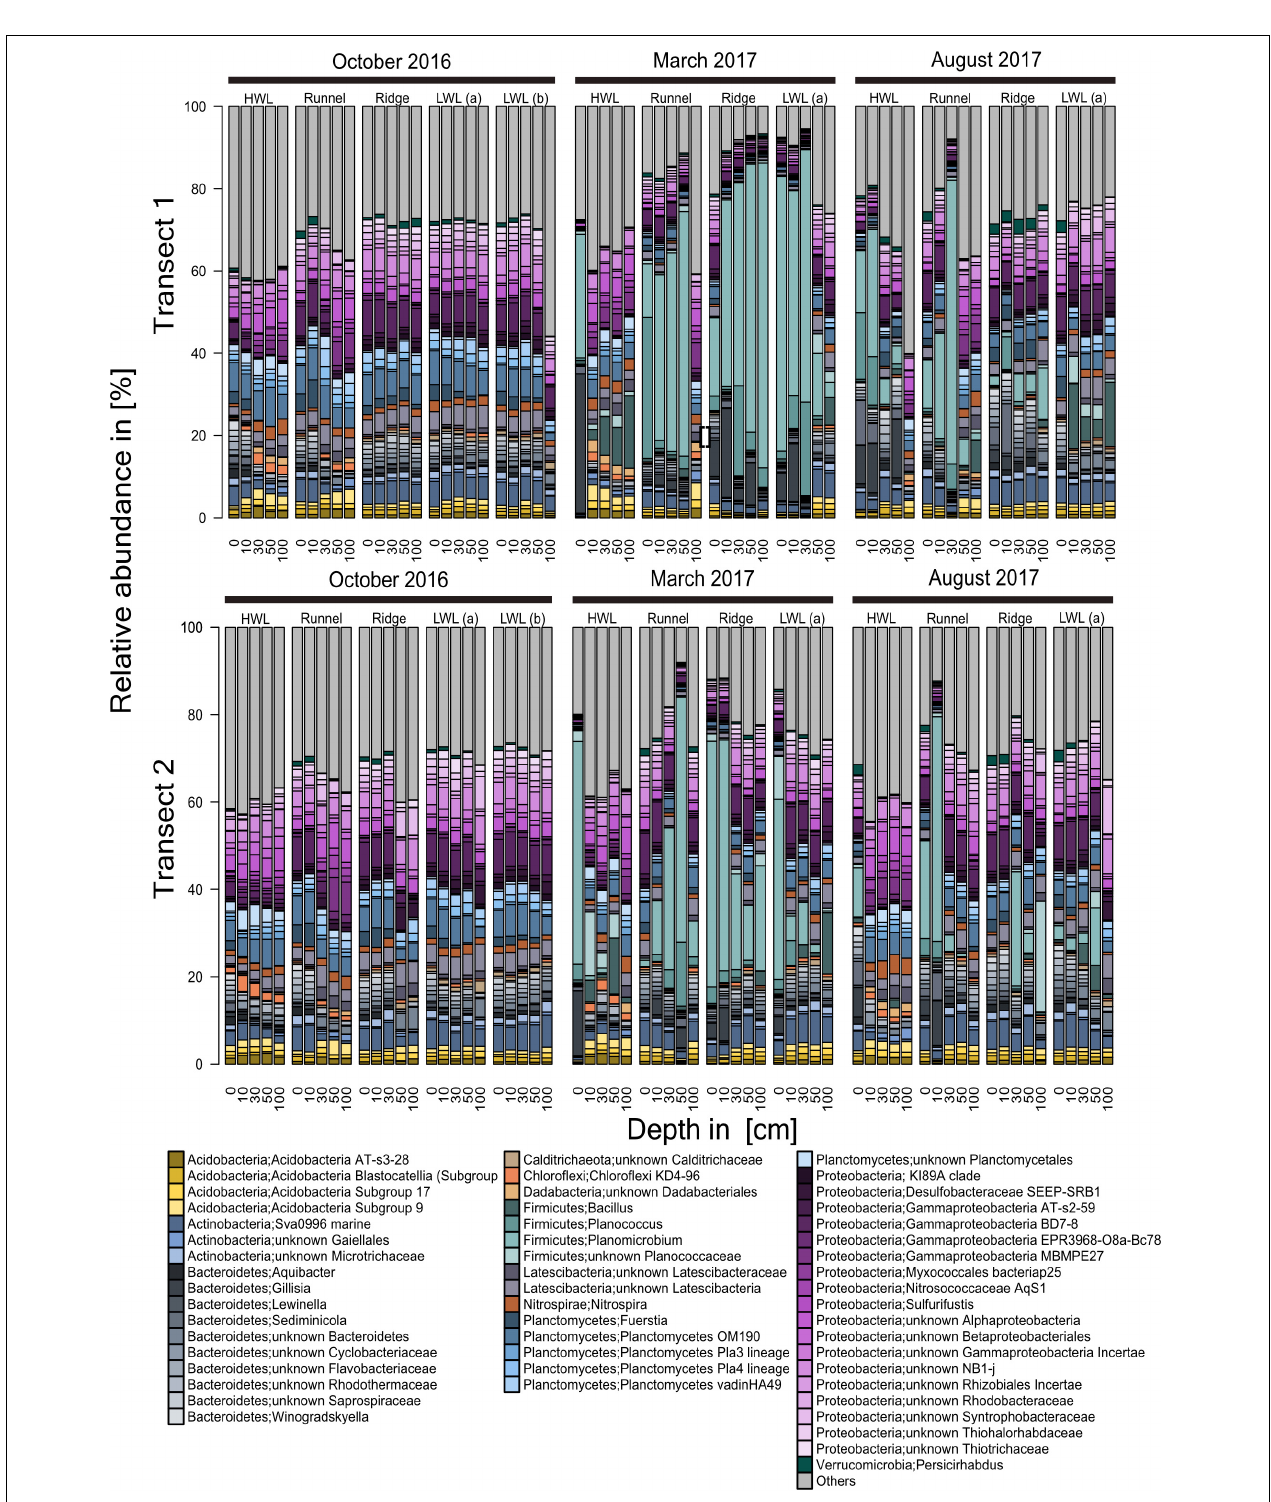
FIGURE 5 | Community composition of transect one and two based on Illumina-sequencing of 16S rRNA genes. Taxonomy is based on ZOTUs, assigned using the SILVA database. The community composition is presented on genus level. Genera with an abundance of < 1%, at 90% of all stations, were combined and are referred to as “others.” From left to right every block represents a sediment core of the individual sampling sites across the intertidal zone, with each bar representing one depth descending from 0 cm down to 100 cm. In October, an additional core (LWL b) was recovered from the LWL. Due to different tidal ranges this site could not be reached in later sampling